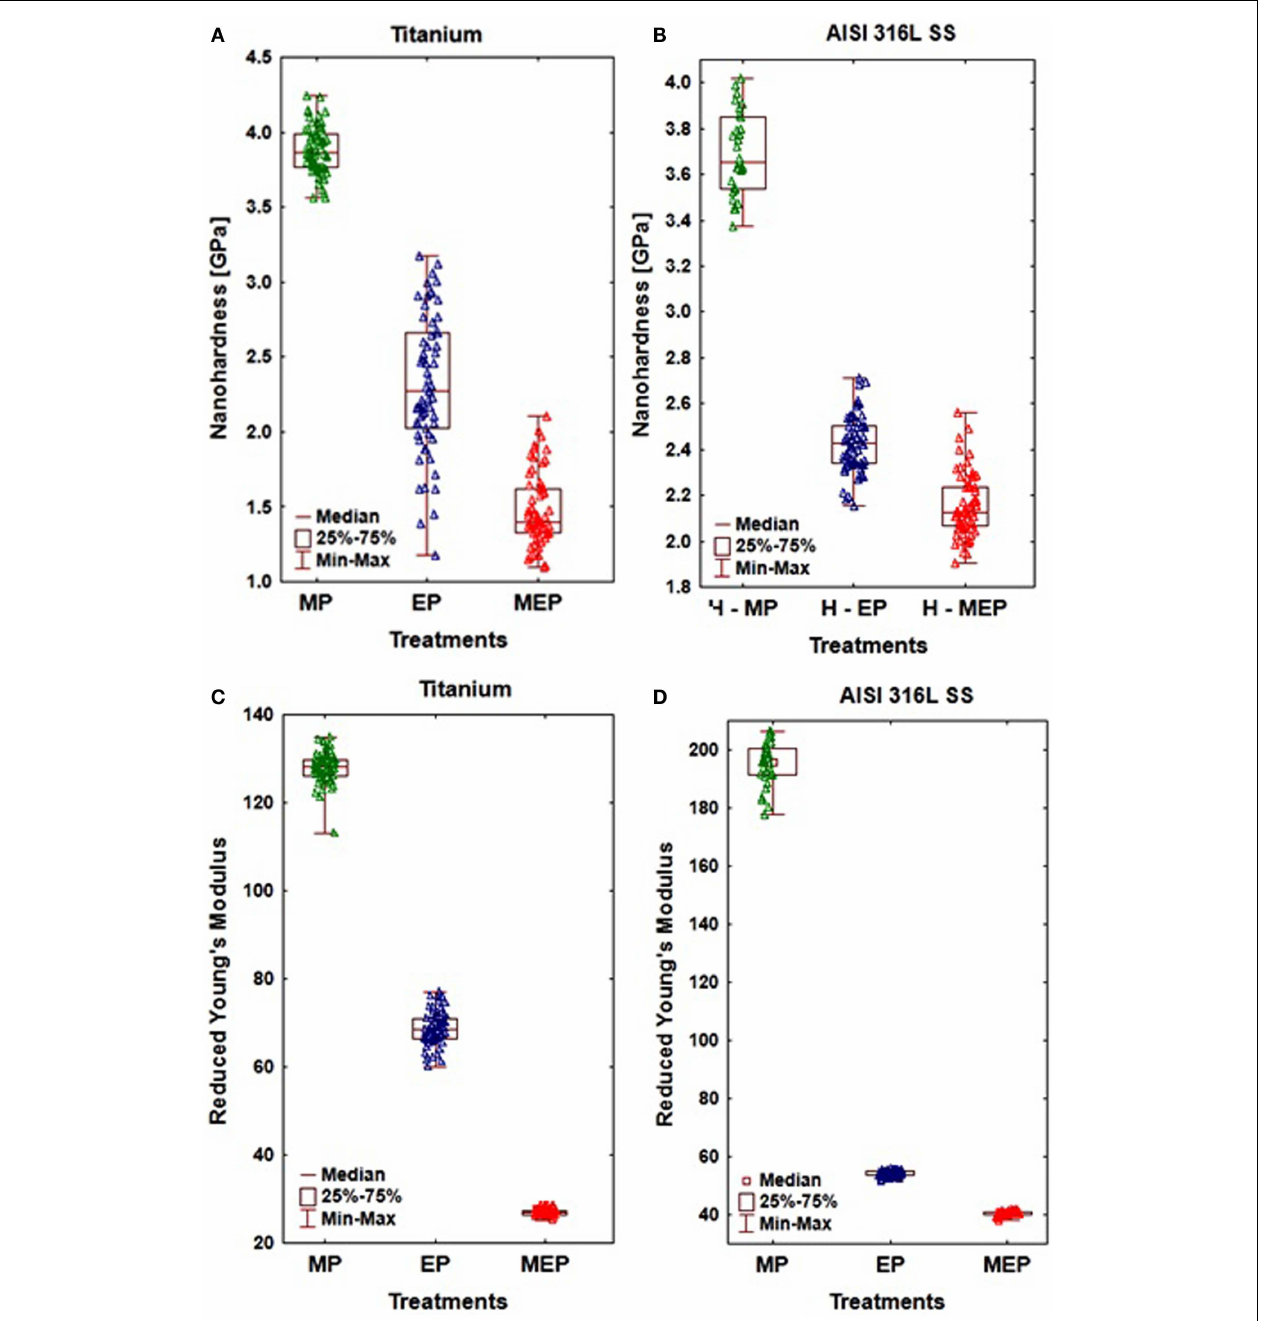
FIGURE 7 |The results of nanoindentation obtained on CPTi Grade 2 (A,C), andAISI 316L SS (B,D) showing: (A,B) nanohardness, (C,D) reduced Young’s modulus .